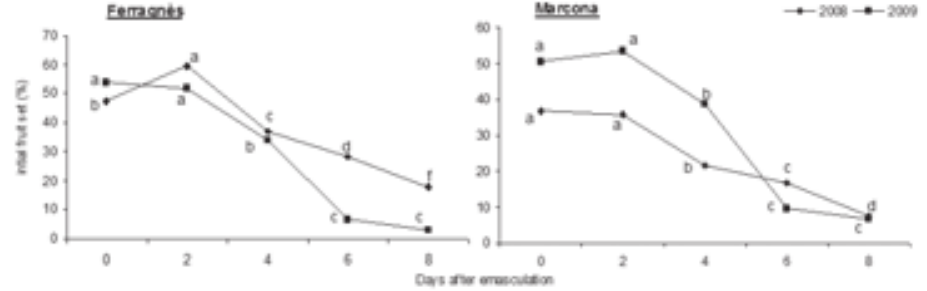
Figure 2. Initial fruit set of the studied cultivars after pollination dates from emasculation (day-0) to day-8 over two consecutive years. Different letters indicate differences in fruit set between pollination times in each year ( P < 0.05)